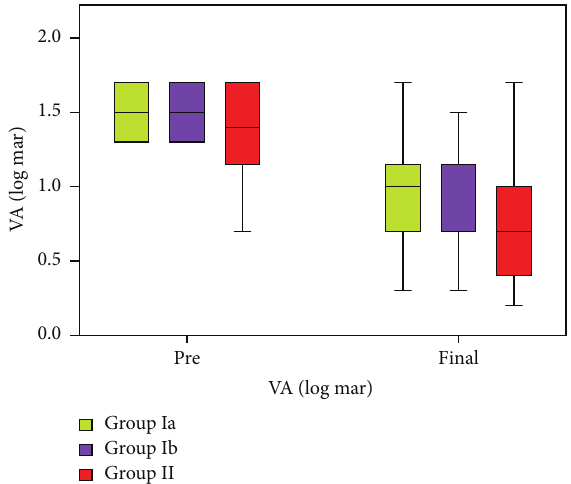
Figure 3: Comparison between the studied groups in relation to preoperative and final visual acuity (VA) in log